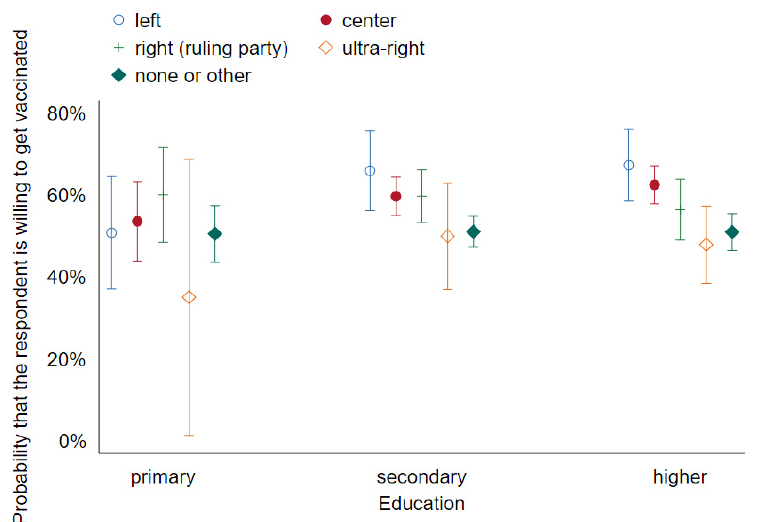
Figure 4. Predictive margins of education and voting preferences on vaccination decision with 95% CIs (Wave